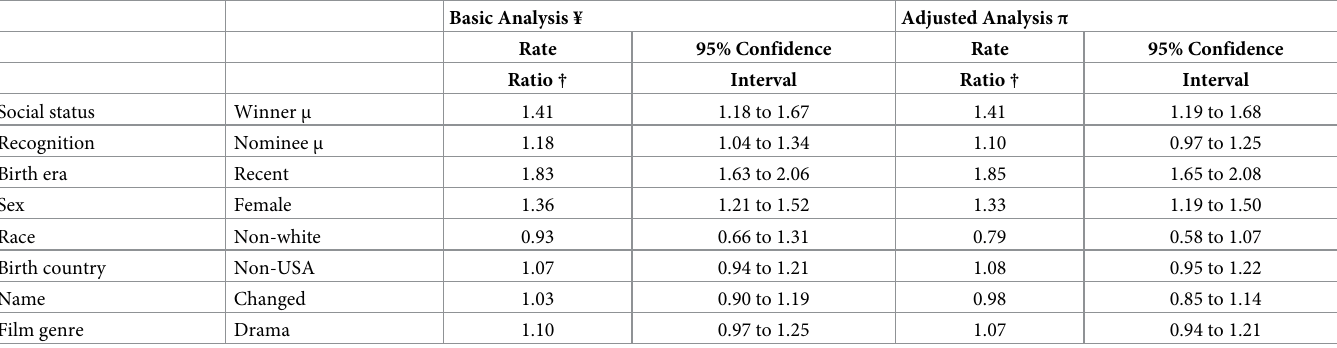
Table 3. Hazard ratios from proportional hazards analysis �